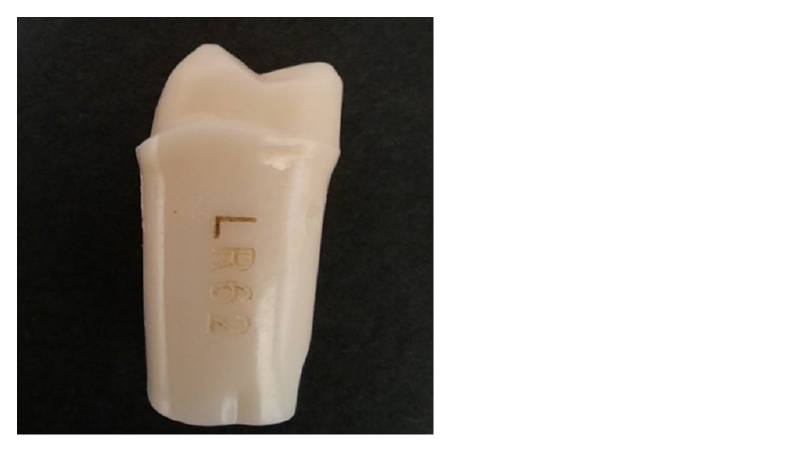
Figure 2. PEEK dental crown was cemented on artificial tooth abutment and embedded in epoxy for compression test. Figure 1. Artificial tooth abutment (LR 62, Nissin Dental Products, Inc., Kyoto, Japan) used in this study.